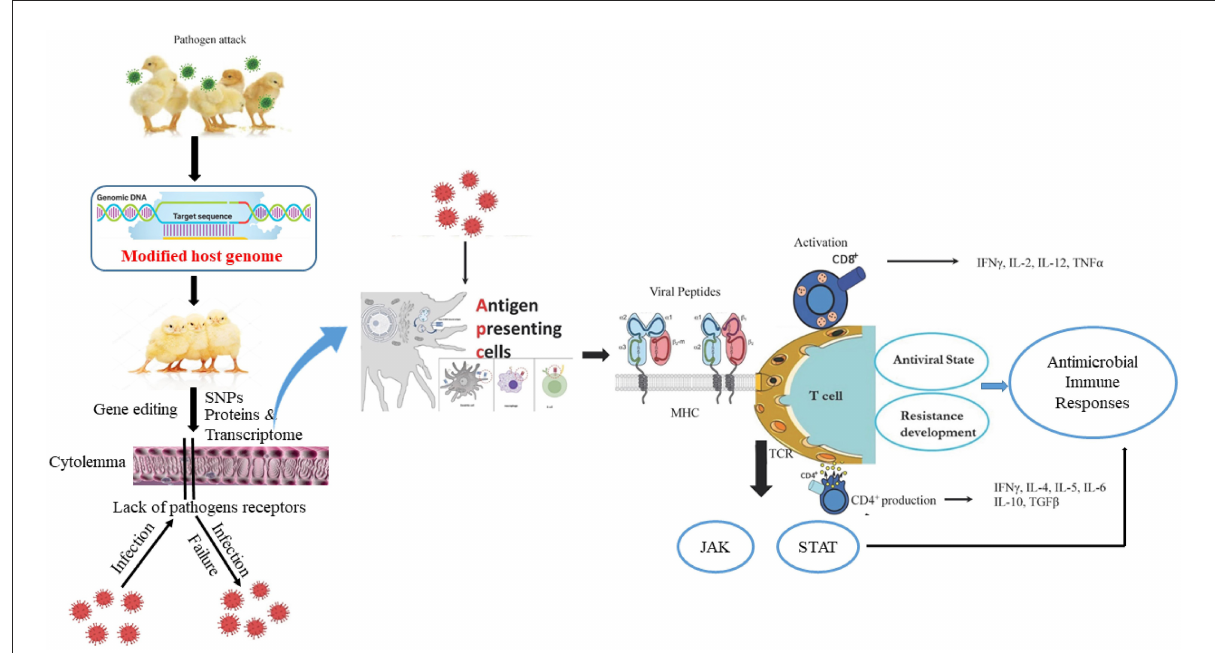
FIGURE1 The host edited-genome and active immune responses of chicken during pathogen attack. Usually, chicken antigen presenting cells (dendritic cell, macrophage, B cell) engulf, digest, and present pathogen antigen on the cell surface in conjunction with an MHC molecule. The MHC/peptide complex stimulates the TCR and activates CD4 + and CD8 + cells. Accordingly, cytokines are produced, cell-signaling pathways such as JAK/STAT are activated, and a disease resistance state is developed inside the chicken that counters the pathogen